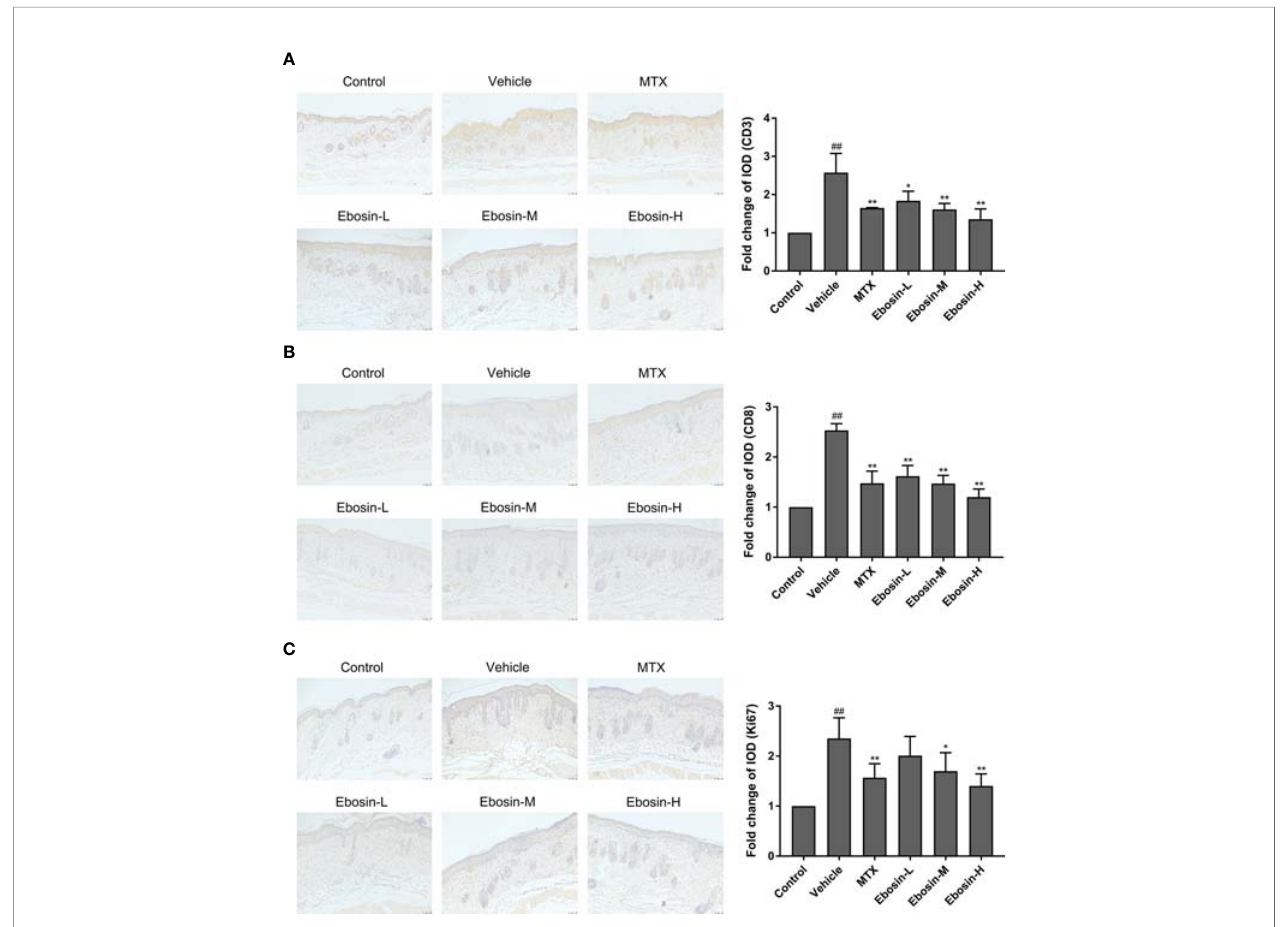
FIGURE 3 | Ebosin inhibits CD3 + and CD8 + T cell in fi ltration and epidermal hyperplasia in skin of psoriatic mice (scale bar is 50 m m). (A) Immunohistochemical images of CD3 staining (magni fi cation: 100×) of dorsal skin and the relative IOD of control (mean ± SD, n = 3). (B) Immunohistochemical images of CD8 staining (magni fi cation: 100×) of dorsal skin and the relative IOD of control (mean ± SD, n = 3). (C) Immunohistochemical images of Ki67 staining (magni fi cation: 100×) of dorsal skin and the relative IOD of control (mean ± SD, n = 3). ## P < 0.01 vs. control; * P < 0.05, **P < 0.01 vs. IMQ-induced vehicle